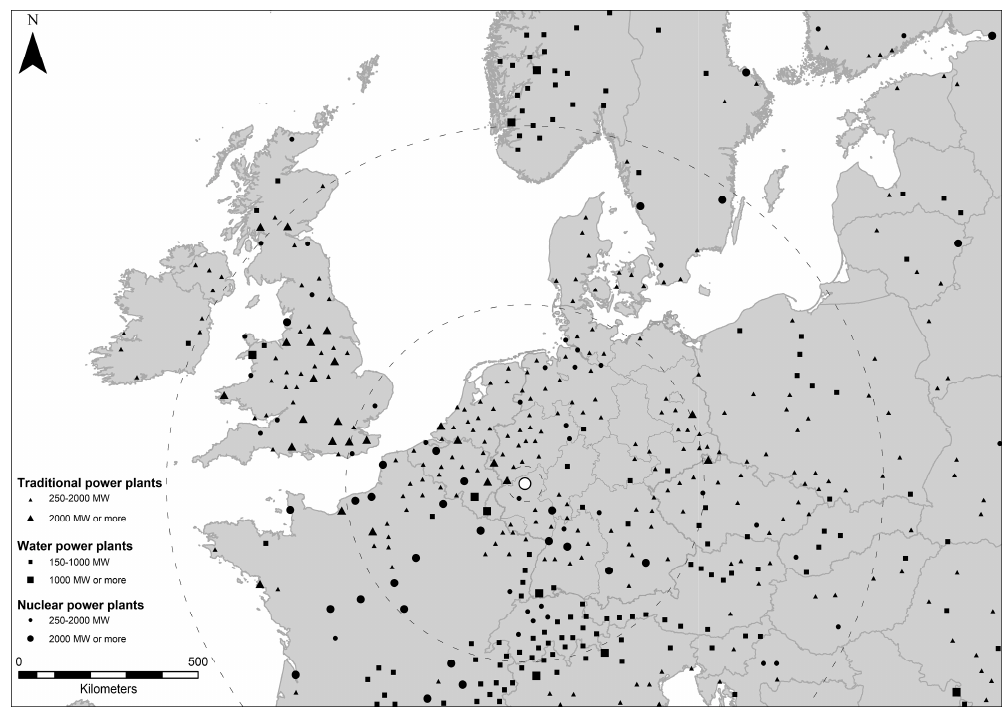
Figure 7. The location of power plants in Europe and the currently known distribution of Laacher See fallout. Stippled lines mark the proximal (<50 km, medial (50–500 km), distal (500–1000 km) and ultra-distal (>1000 km)) hazard zones, as in Figure 5. Redrawn from